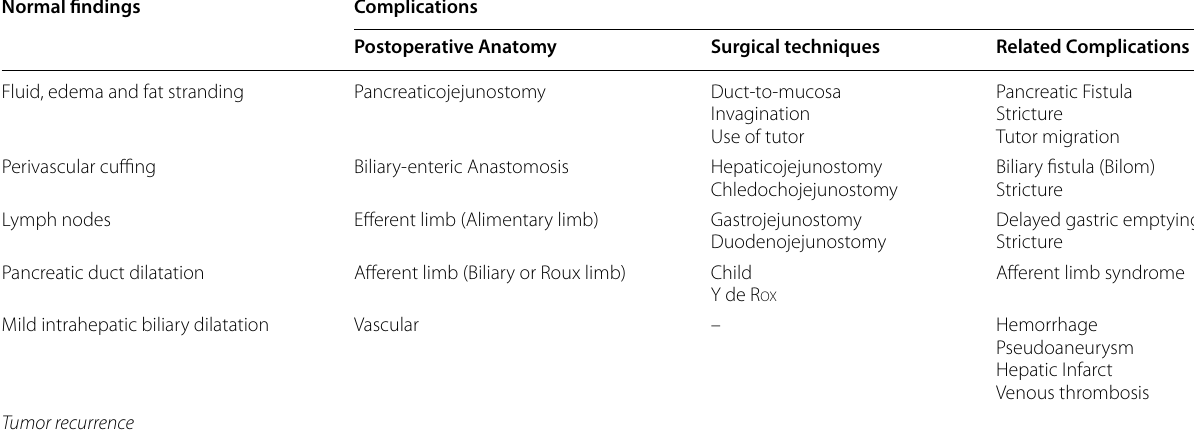
Table 1 Normal findings and complications Normal findings